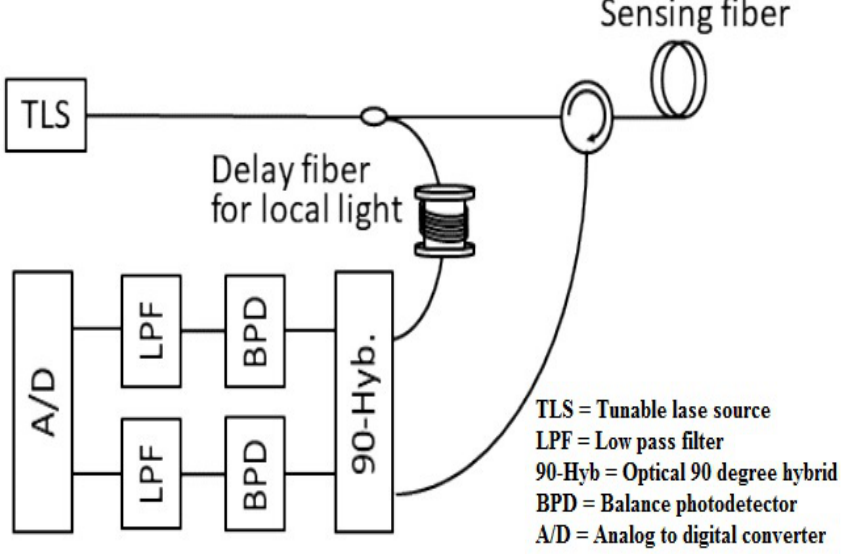
Figure 3. Comparative distance estimations by the OFDR framework.